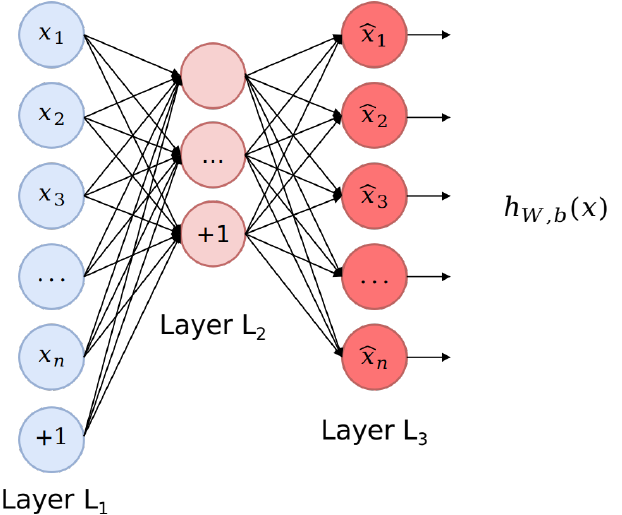
Figure 8. Conceptual diagram of an